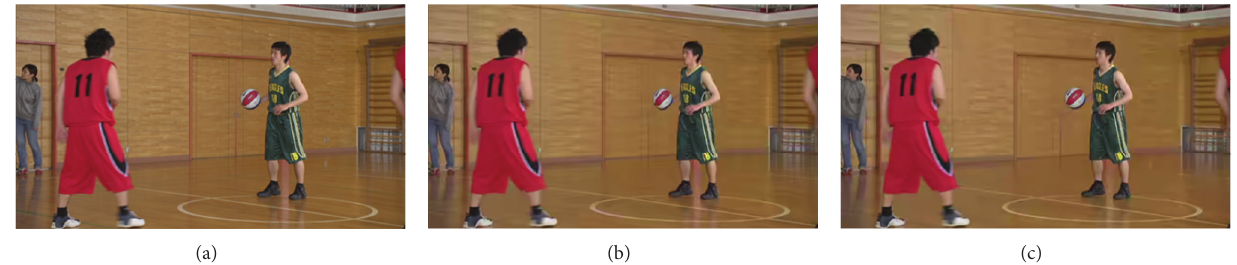
Figure 4: Frame from Basketballpass test video: (a) original video, (b) encoded video using existing HM encoder, and (c) encoded video using proposed DCT algorithm.